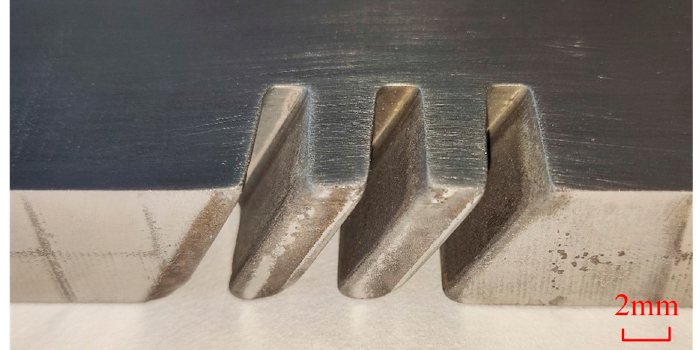
Figure 15. Machined specimen with the channels.